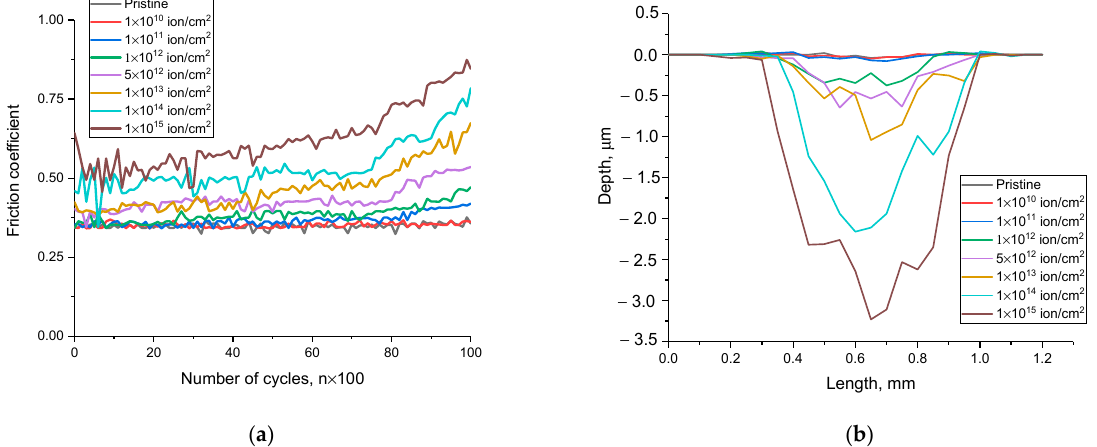
Figure 10. ( a ) Results of tribological tests to determine the coefficient of dry friction; ( b ) evaluation of the profile of the damaged layer after tests to determine the coefficient of dry friction. An increase in the irradiation fluence above 10 11 ions/cm 2 lead to an increase in the initial value of the dry friction coefficient, which was associated with the formation of defor- mation inclusions in the near-surface layer during the accumulation of radiation damage. At the same time, changes during long-term wear resistance tests indicate that deformation inclusions not only affected the increase in the friction coefficient after 7000–8000 cyclic tests, but also lead to an increase in the depth of the trace profile from the rubbing body, as well as its width. Such a change in the profile indicates destructive wear of the near-surface layer and its embrittlement, which lead to an increase in surface wear. At irradiation fluences of 10 14 –10 15 ion/cm 2 , the initial value of the dry friction coefficient increased by 50–70% compared to the initial value, which indicates an increase in the concentration of deformation inclusions in the near-surface layer, which increase the friction resistance. It is also worth noting that surface degradation during long-term testing occurs much earlier for these irradiation fluences, which indicates the destructive nature of the accumulated damage in the near-surface layer, leading not only to bulk swelling, but also to rapid wear of the surface (see the data on changes in the depth profile in Figure